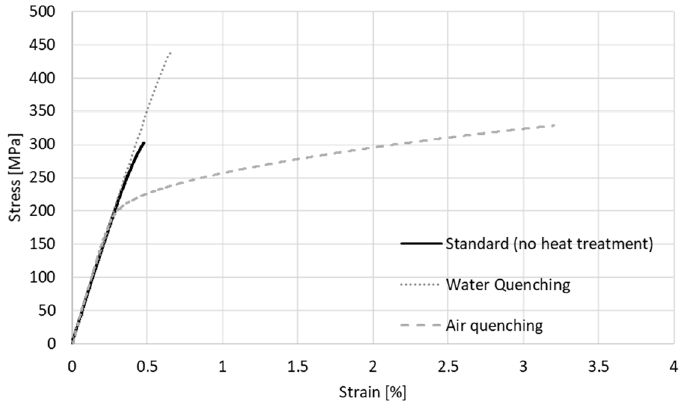
Figure 11. Stress-strain-curves of the welded and PWHT tensile specimen.